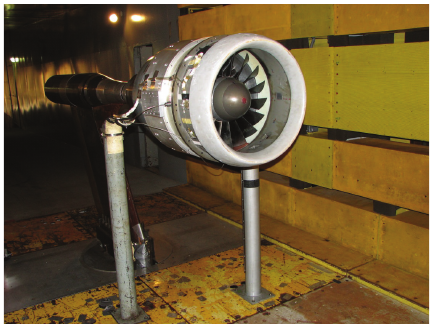
Figure 2: Axial vane fan located at the 10 × 10 SWT. Figure 3: NASA